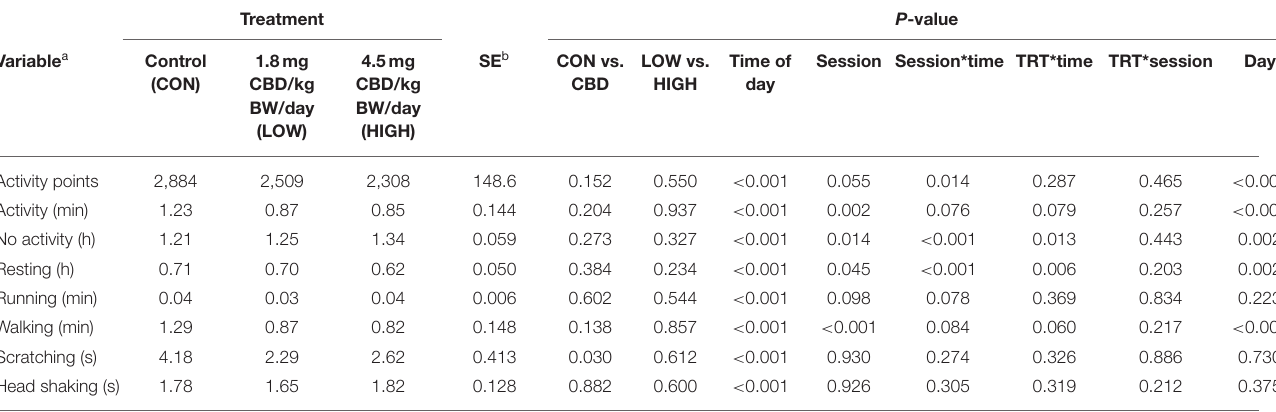
TABLE 4 | Effect of treatment (TRT), day, session (Quiet or Music), time of day (a.m. or p.m.), and all relevant interactions on activity variables collected via Vetrax ® activity sensors (AgLogica Technology, Norcross, GA) at 1,000–1,200h (a.m.) and 1,330–1,530h (p.m.) each day. Treatment P